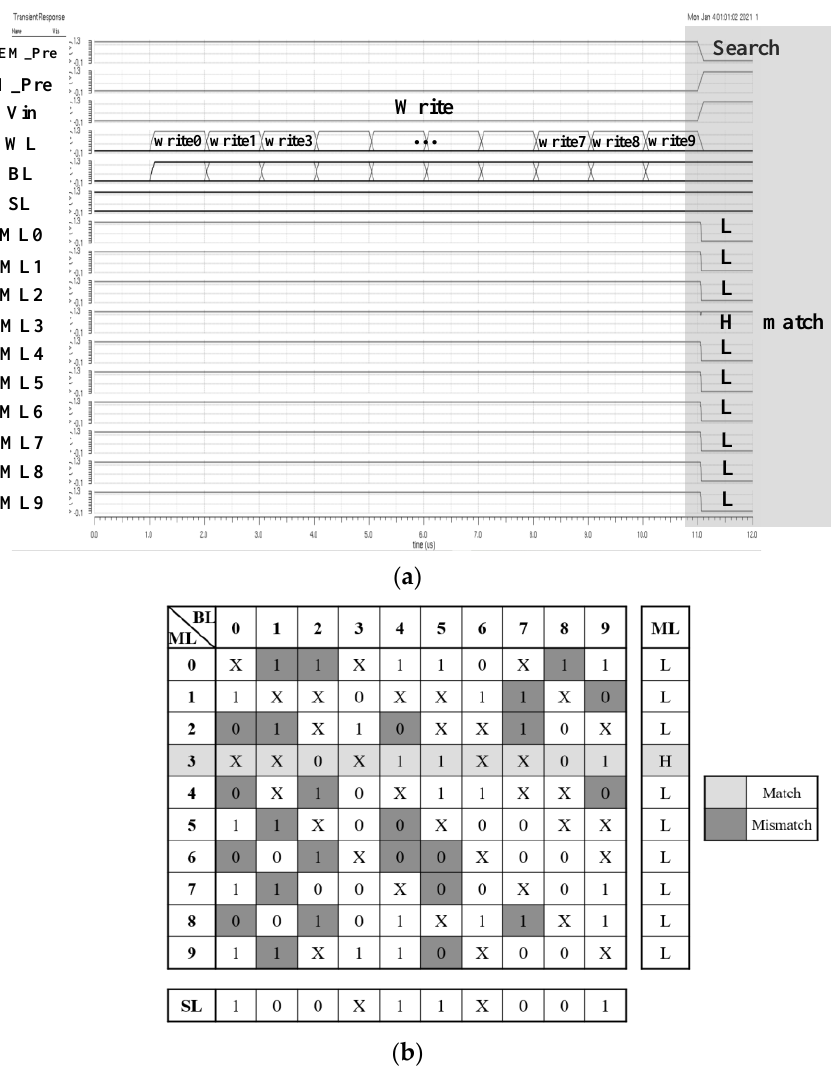
Figure 14. Post-layout simulation of the NEM-based TCAM10 × 10 array. ( a ) Transient simulation; and ( b ) test bench.